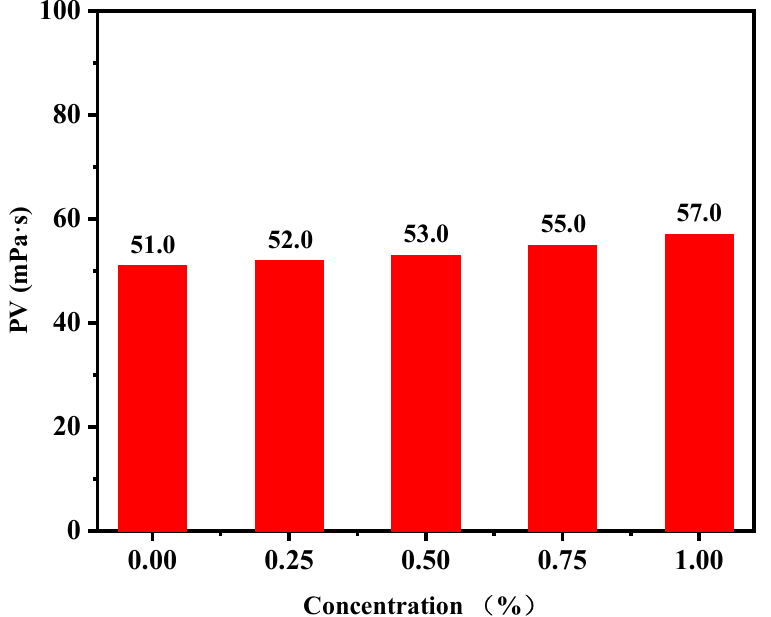
Figure 5. PV change curve after aging of oil-based drilling fluids with the addition of poly (MMA-BA-ST).